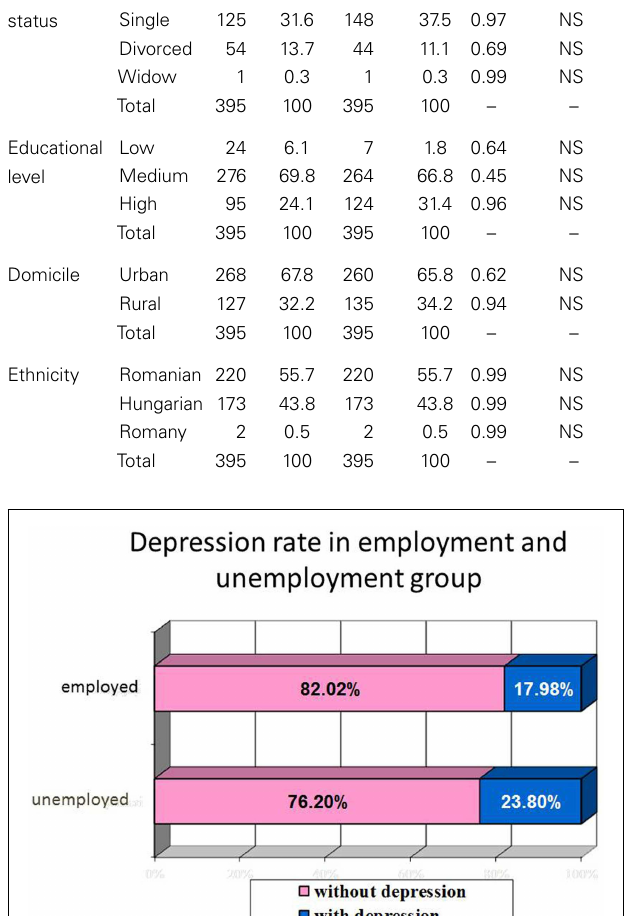
unemployed group, but in the unemployed group the women were found with significantly more severe depression than in men ( p = 0.01).